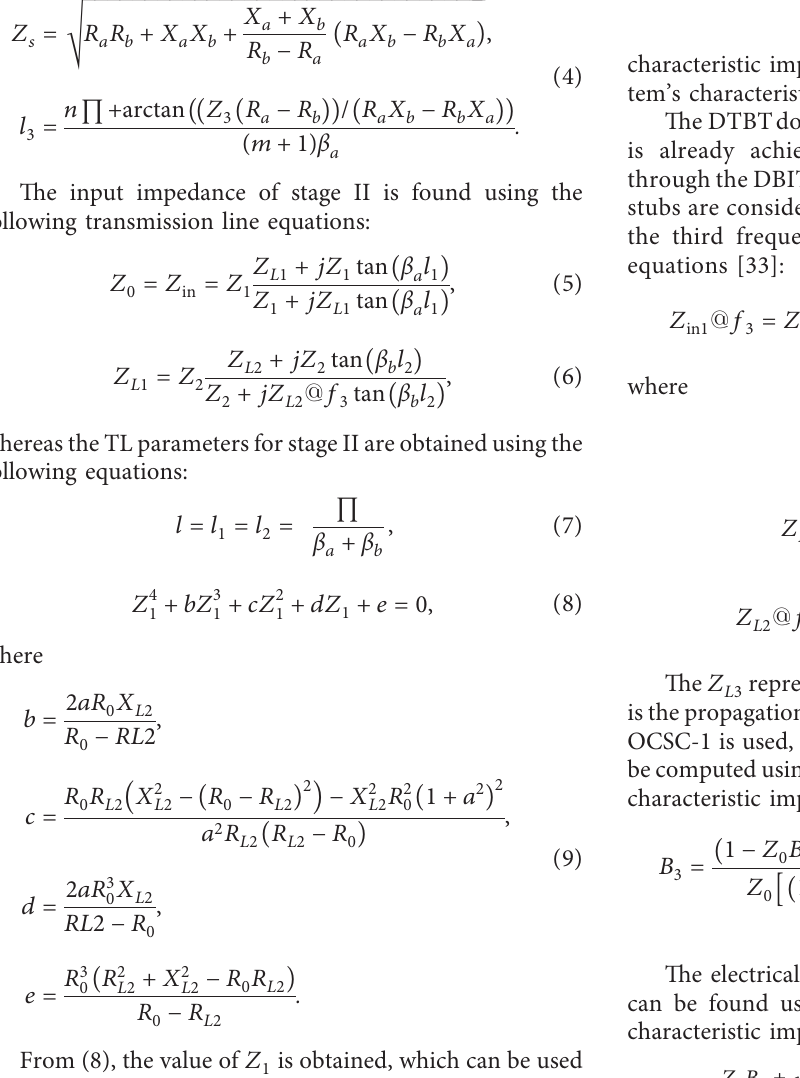
Figure 21: Block diagram of the Dual Band Impedance Trans- former (DBIT).